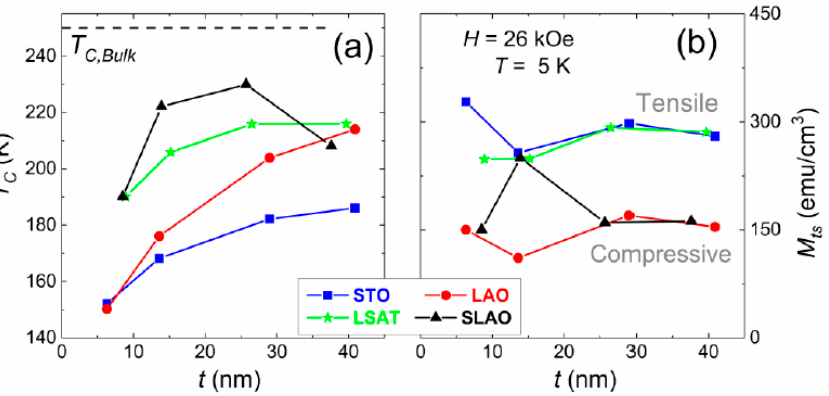
Figure 6. ( a ) Curie temperature (T C ) dependence on the thickness and the substrate-induced strain; the dashed line at 250 K corresponds to the T C value for LSCO bulk. ( b ) Saturation magnetization (M ts ) at 5 K for LSCO films grown on STO, LSAT, LAO, and SLAO substrates.